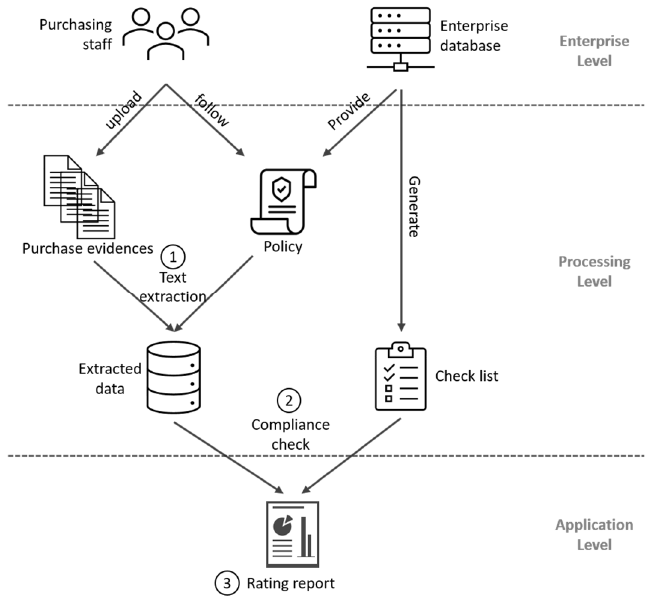
Figure 3 . The workflow of CoCAF . Figure 3. The workflow of